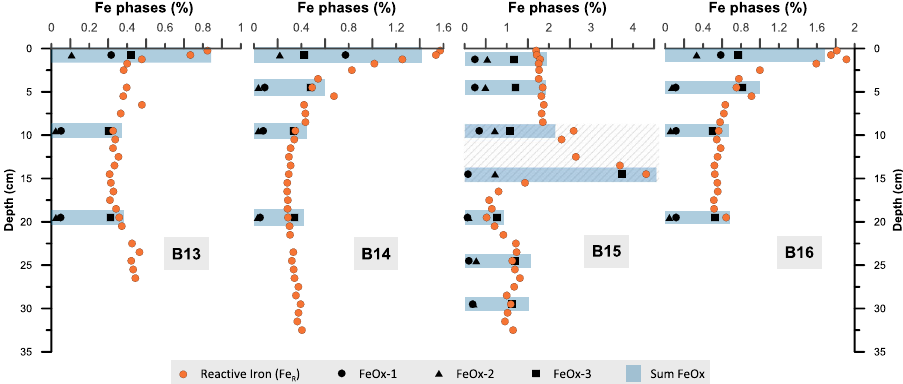
Fig. 3 Comparison between the downcore pro fi les of reactive iron (Fe R ) 13 and the results of the sequential iron extraction 75 . The three iron phases from the sequential iron extraction, shown by black circles, triangles and squares, are: Fe bound to carbonates or very labile iron oxides (FeOx-1); poorly crystalline Fe (oxyhydr)oxides like ferrihydrite (FeOx-2) and crystalline Fe (oxyhydr)oxides such as hematite and goethite (FeOx-3). Blue bars indicate the sum of FeOx1 – 3 which shows that the dithionite extraction of Fe R (orange dots) represents the entire reactive iron pool. The grey hatched area (B15) indicates a pink, iron-rich sediment layer, which is enriched in more crystalline iron phases